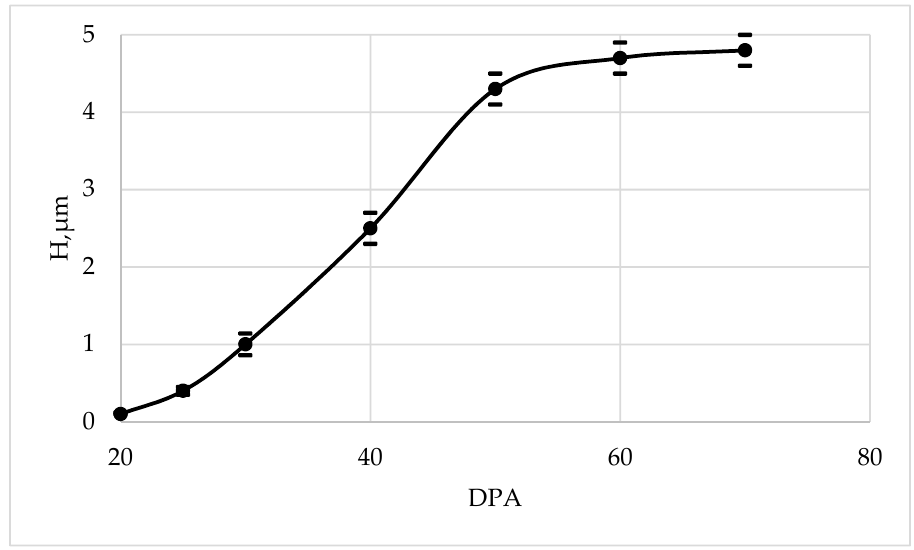
Figure 1. Dependence of cell wall thickness on days post anthesis (DPA) of cotton fibers. Thickening of the cell wall with increasing DPA leads to a decrease in specific pore volume (P), Table 1. Characteristics of cotton fibers of various age. but to enhance in apparent density ( (cid:37) ) of cotton fibers (Table